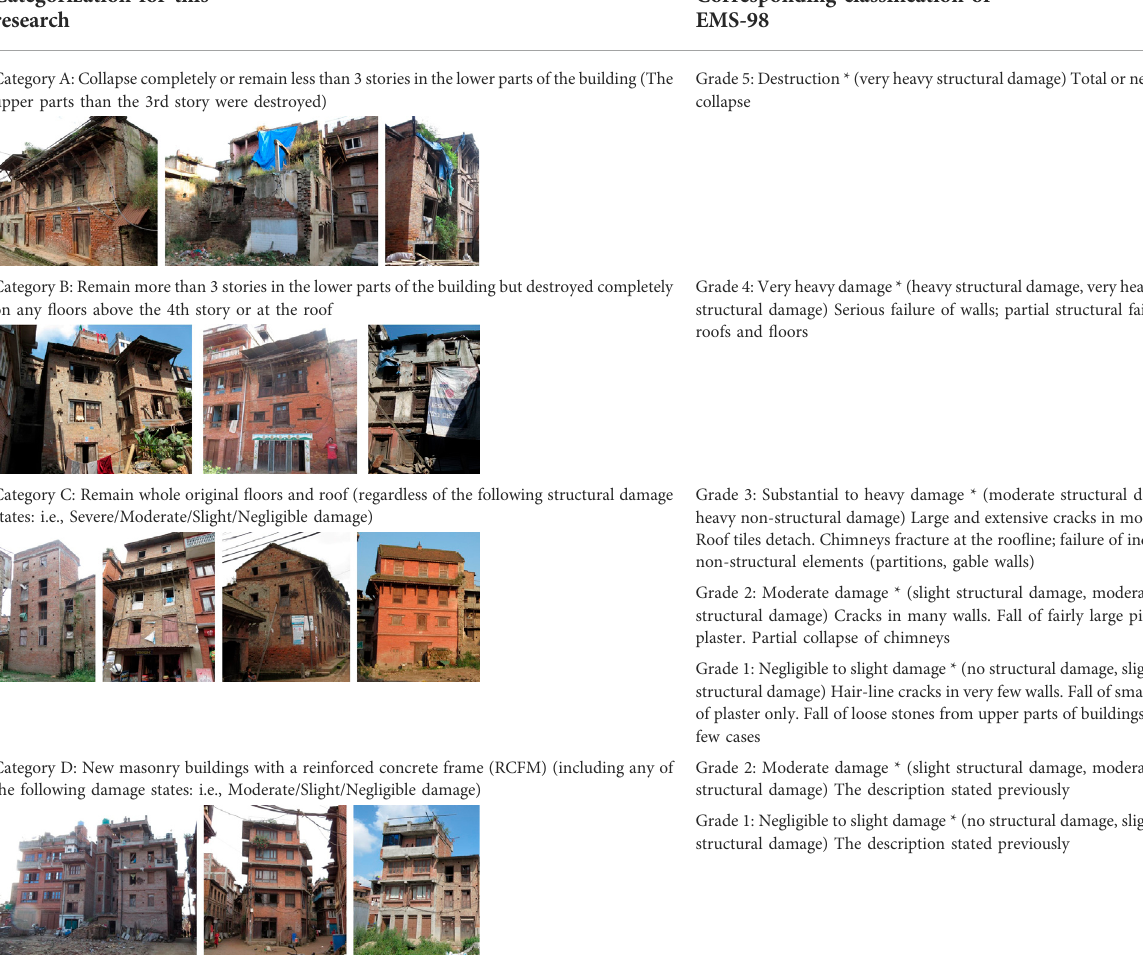
TABLE 1 Categorization of damage degree of